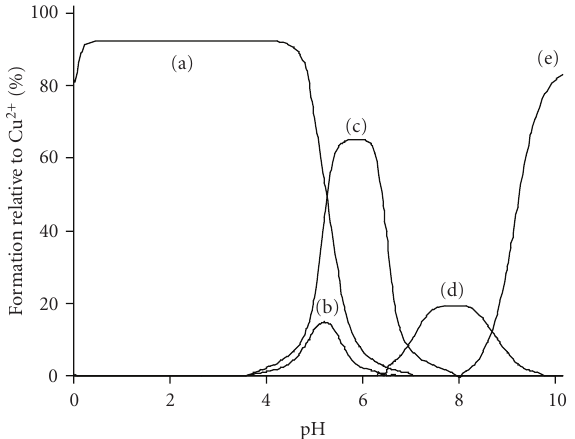
Figure 3: Species distribution (% formation relative to Cu 2+ ) in the Cu(II)-H 4 cacp system at equimolar concentration (5.00mmoldm − 3 ) as a function of pH over the range 2.00– 10.0 (25 ◦ C, I = 0 . 10moldm − 3 KCl, pK w = 13 . 78, γ = 0 . 78).